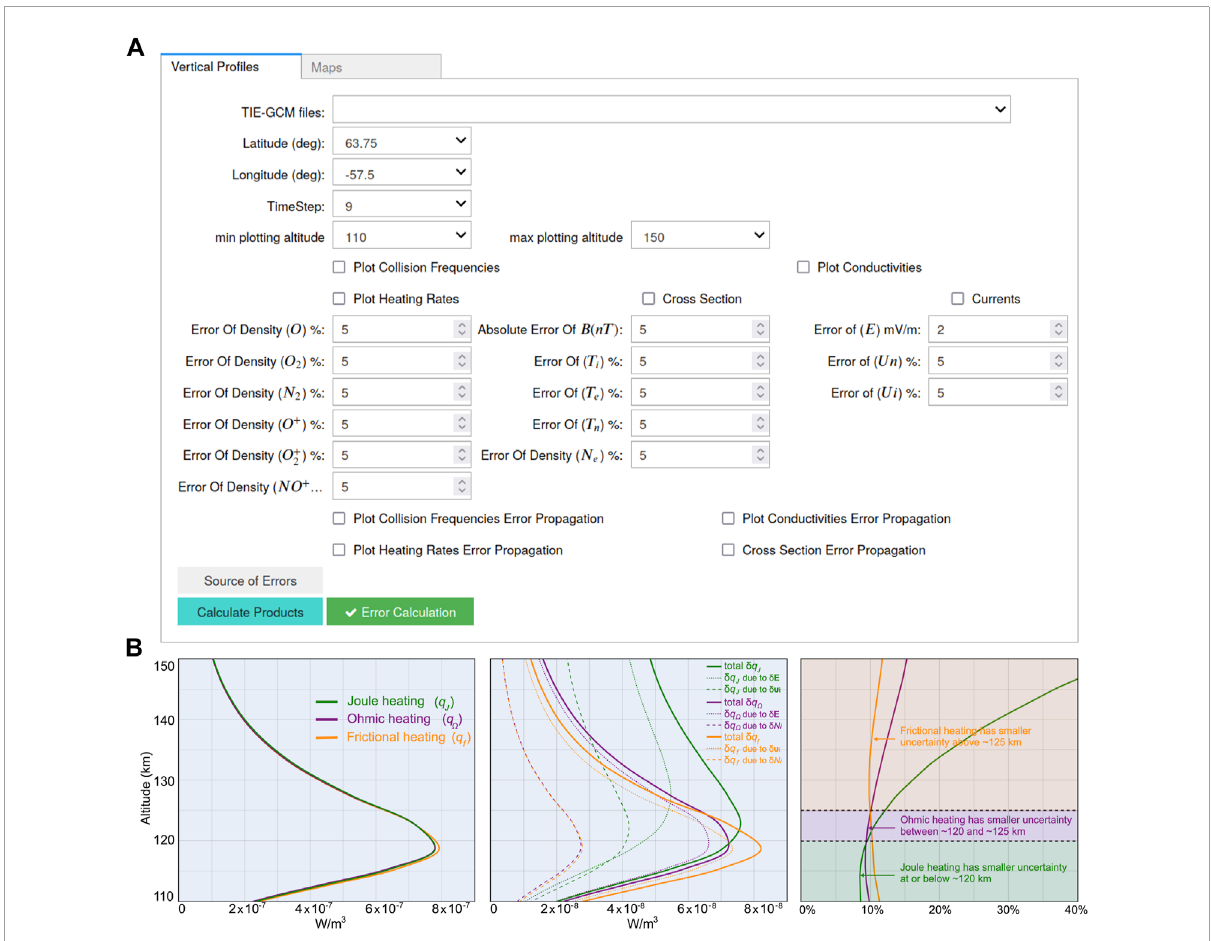
FIGURE 5 (A) : a Graphical user Interface (GUI) for the selection of parameters of the error propagation, such as the location, derived product and errors per geophysical observables. (B) : Example of Joule heating total uncertainty propagation for a vertical profile at 63 . 75 o latitude, − 57 . 5 o longitude, 2015-03-17 18:00, for the three estimation methods. Left, profiles as drawn from TIEGCM grid column. Middle, absolute total uncertainties, and principal contributors to total uncertainty (electric field δ E, ion drift δ vi, and ion number density δ Ni). Right, relative total uncertainties in E